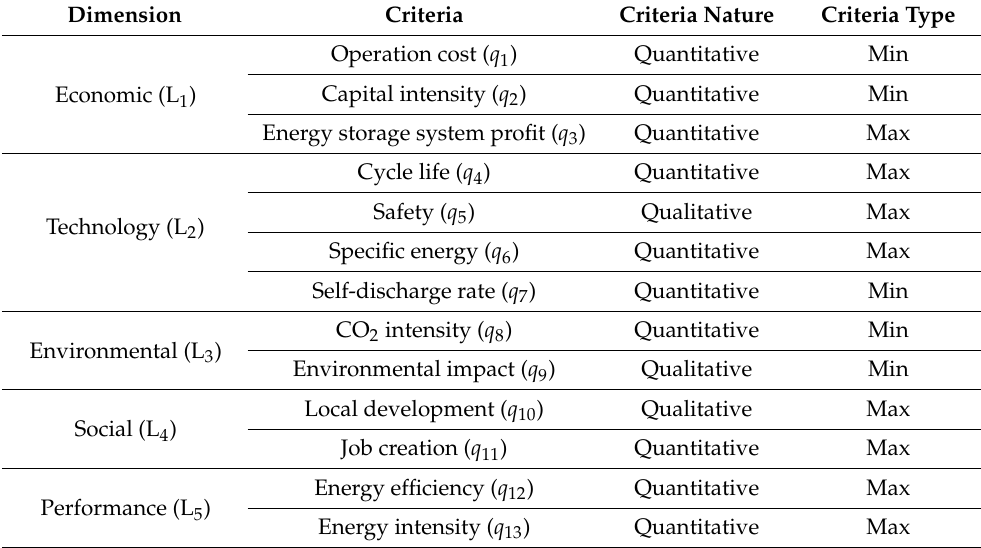
Table 1. Comprehensive assessment indicators for prioritizing BESSs.